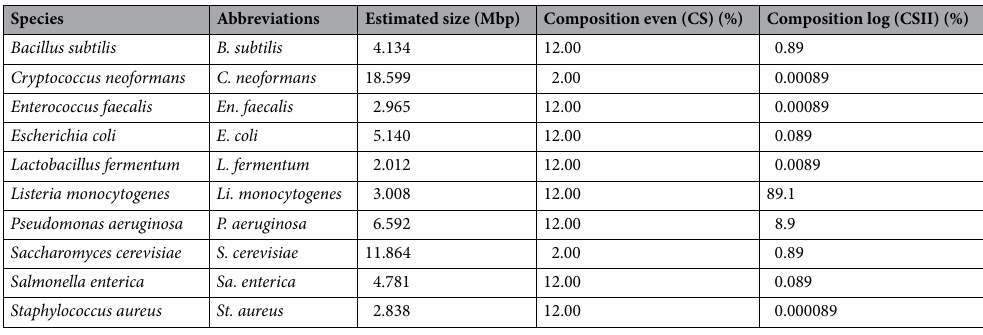
Table 1. Description of the microorganisms comprising the ZymoBIOMICS mock communities and their theoretical